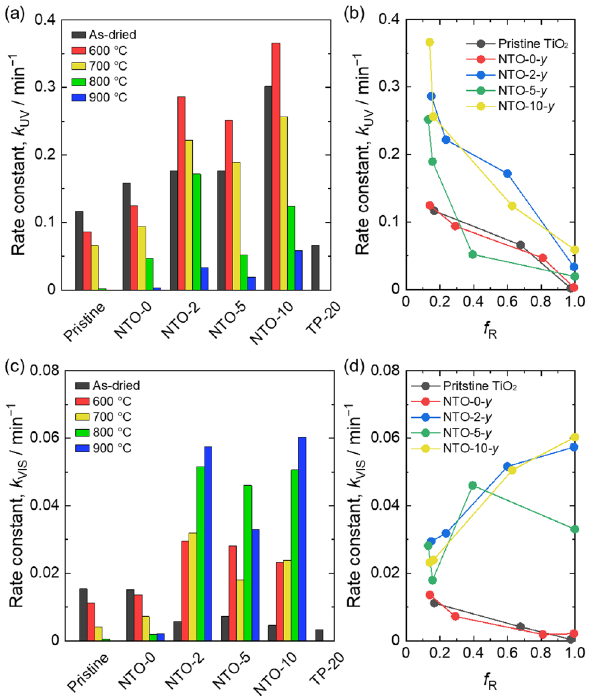
Figure 7. Rate constants, k UV and k VIS , of photocatalytic decoloration of MO under irradiation of ( a ) UV-light and ( c ) VIS-light of P25, NTO-0- y , NTO-0- y , NTO-5- y , NTO-10- y , and TP-20. The plots of f R versus ( b ) k UV and ( d ) k VIS of P25, NTO-0- y , NTO-0- y , NTO-5- y , NTO-10- y , and TP-20 (600 ≤ y ≤